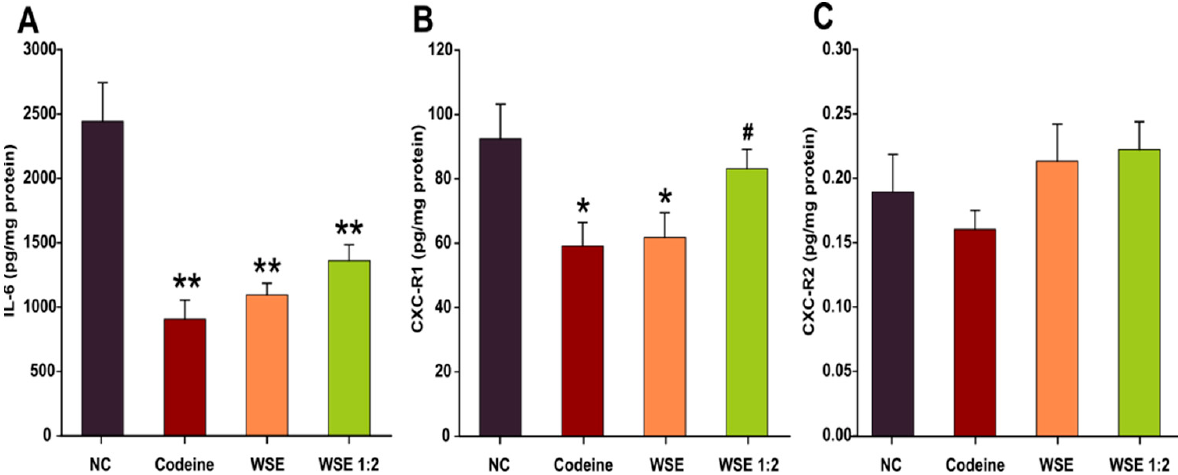
Figure 4. The effects of the treatments on the secretion of pro-inflammatory cytokines and receptors, IL-6 ( A ), CXC-R1 ( B ) and CXC-R2 ( C ) in lung tissue. Values are expressed as mean ± SEM ( n = 6). * p < 0.05 and ** p < 0.01 compared to NC; # p < 0.05 compared to positive control (Codeine). Statistical significance differences in datasets were determined with one-way ANOVA with the Holm-Sidak post hoc test. CXC-R1—chemokine receptor type 1; CXC-R2—chemokine receptor type 2; IL-6—Interleukin 6; NC—negative control; WSE—walnut septum extract; WSE 1:2—walnut septum